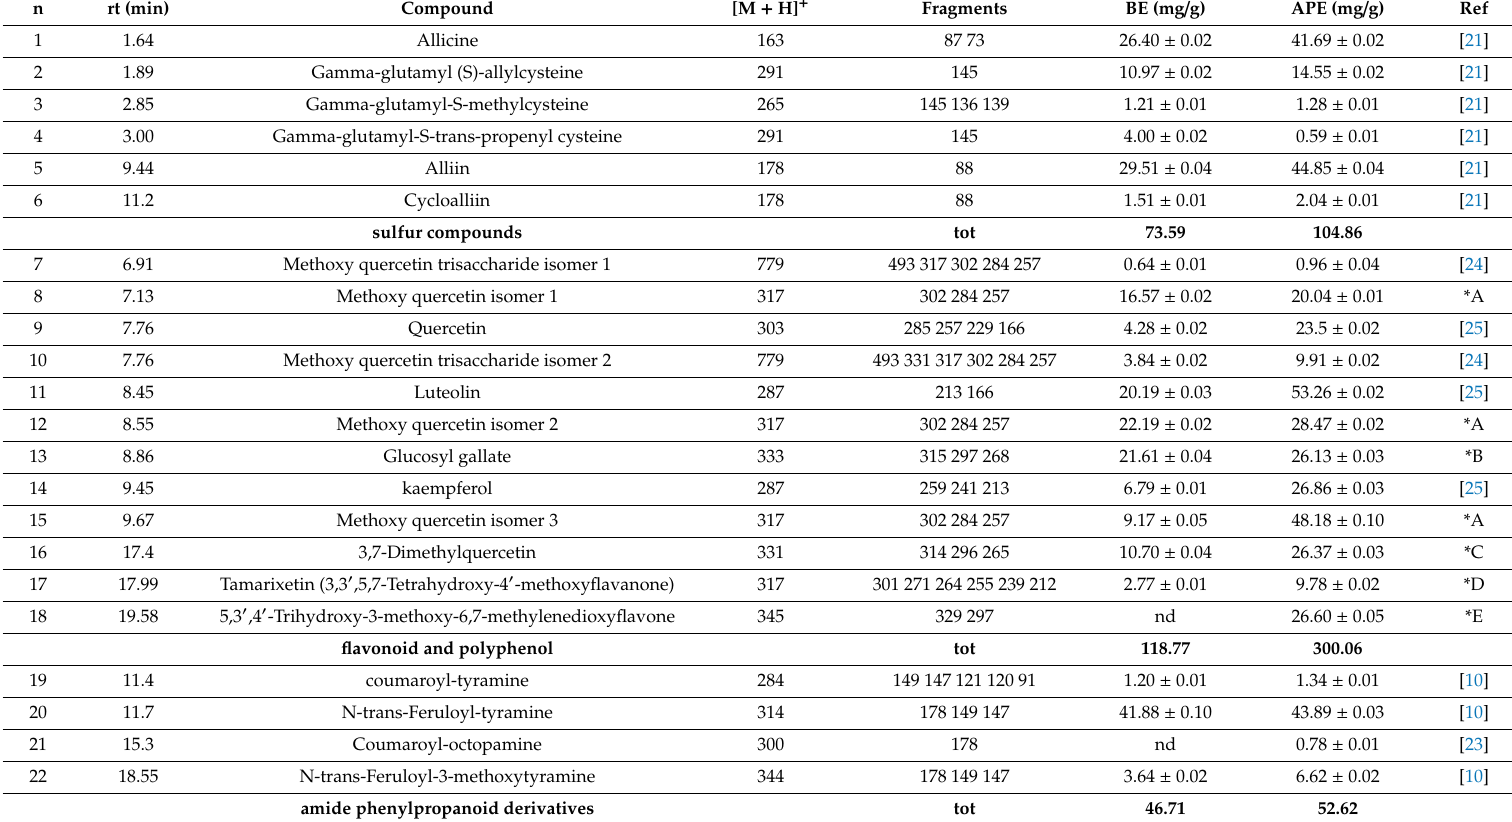
Table 1. Compounds identified in extracts from bulb (BE) and aerial parts (APE) of A. subhirsutum by LC-MS. rt: retention time, nd: not detected, * Food Database (https: // foodb.ca / ): A = FDB000604, B = FDB018376, C = FDB000176, D = FDB016383 E =